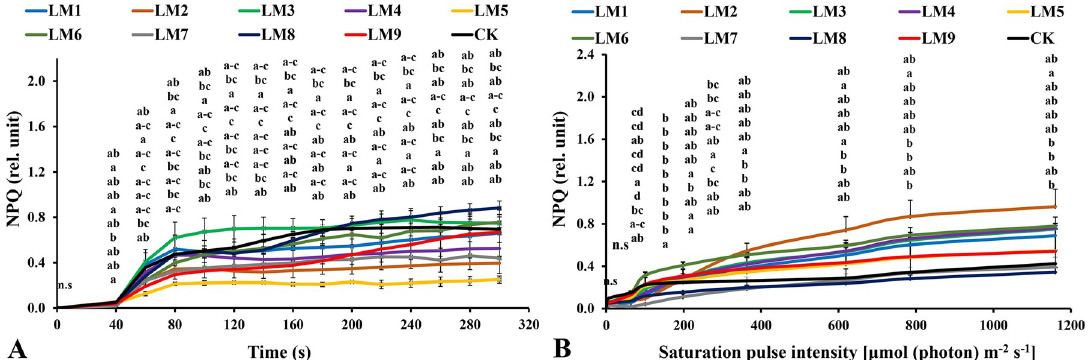
Fig 9. Effects of LED light modes on chlorophyll a fluorescence induction kinetics of the dark-acclimated (A) and RLC of the light- acclimated (B) of non-photochemical quenching (NPQ) in rocket leaves. The points are means ± SE of 4 replicates followed by the same letters meaning no different significantly according to the Duncan test (P � 0.05). Sort significance letters from top to bottom according to the treatments (ML1-CK). LM1 = A1:B1:C1, LM2 = A1:B2:C2, LM3 = A1:B3:C3, LM4 = A2:B1:C2, LM5 = A2:B2:C3, LM6 = A2:B3: C1, LM7 = A3:B1:C3, LM8 = A3:B2:C1, LM9 = A3:B3:C1, CK = White fluorescent light.